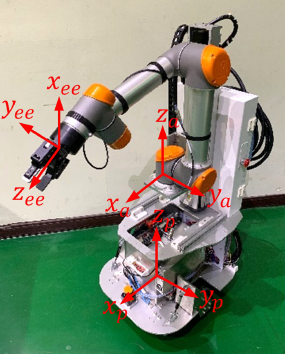
Figure 4. Nonholonomic mobile manipulator used for the